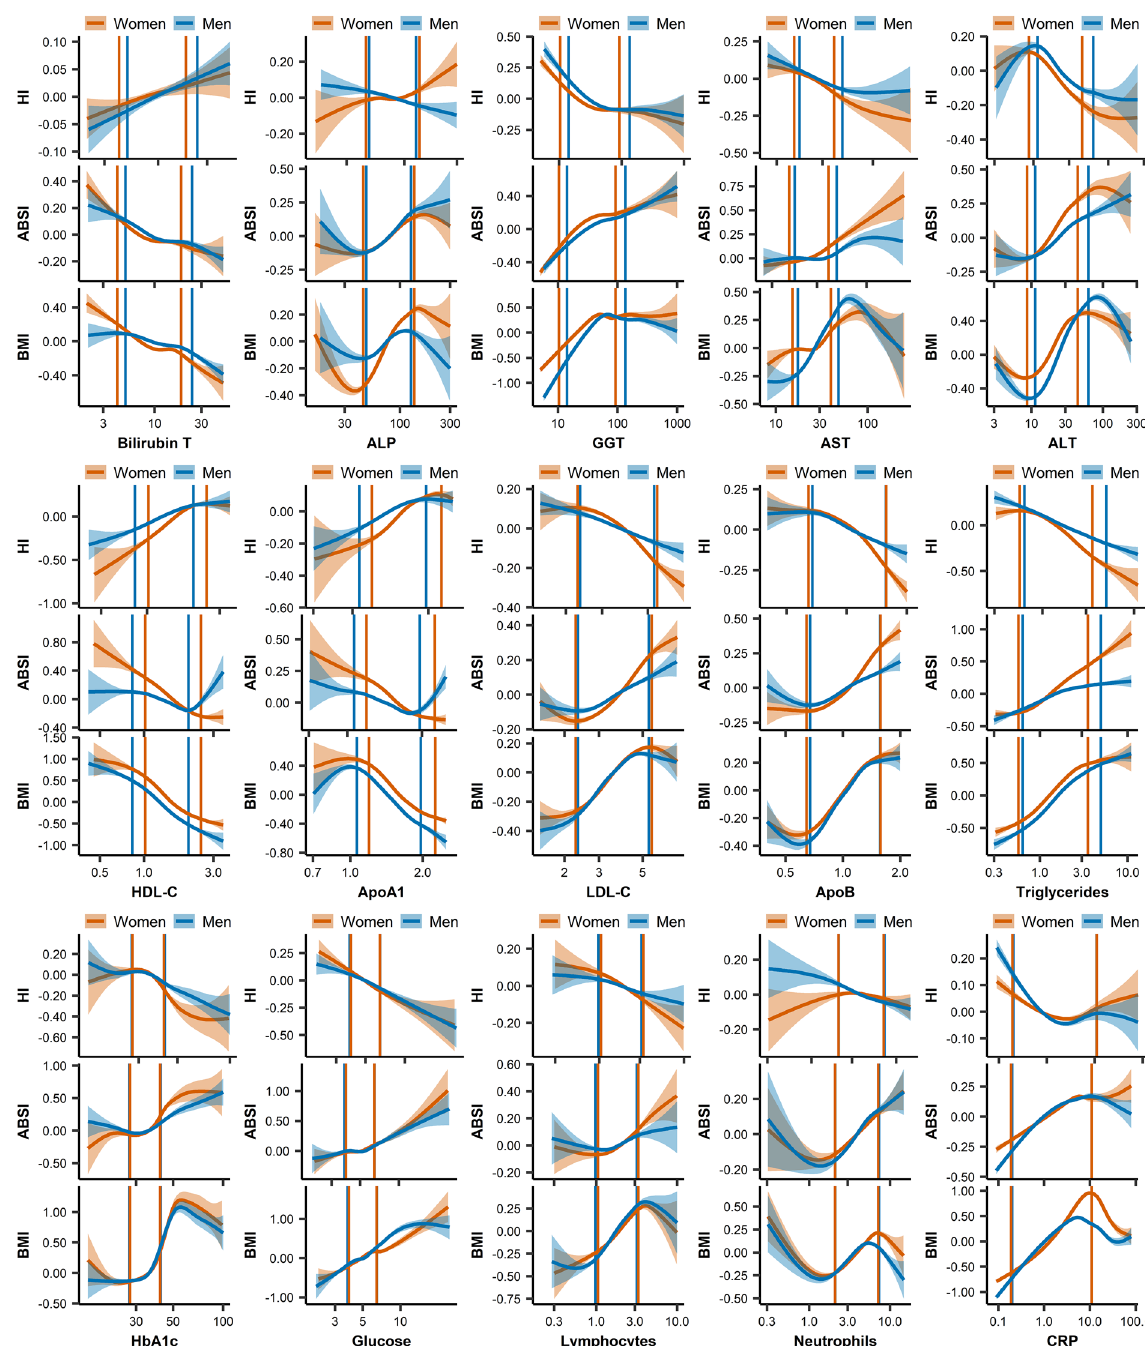
Figure 4. Associations of biomarkers with body size and body shape indices across biomarker levels. ABSI – a body shape index; ALP – alkaline phosphatase (U/L); ALT – alanine aminotransferase (U/L); ApoA1 – apolipoprotein A1 (g/L); ApoB – apolipoprotein B (g/L); AST – aspartate aminotransferase (U/L); Bilirubin T – total bilirubin ( µ mol/L); BMI – body mass index; CRP – C-reactive protein (mg/L); GGT – gamma-glutamyltransferase (U/L); Glucose (mmol/L); HbA1c – haemoglobin A1c (glycated haemoglobin) (mmol/mol); HDL-C – high-density lipoprotein cholesterol (mmol/L); HI – hip index (cut-offs ≥ 49 for men, ≥ 64 for women); LDL-C – low-density lipoprotein cholesterol (mmol/L); Lymphocytes (*10 9 /L); Neutrophils (*10 9 /L); Triglycerides (mmol/L). Plots represent mean of biomarker levels (95% confidence interval), determined with the generalised additive models smoothing function from package mgcv v1.8–39, applied in ggplot2 v.3.3.5 in R v4.1.3., which uses restricted maximum likelihood (REML) estimation. Vertical lines represent 2.5th and 97.5 th sex-specific centiles of the dataset. Extreme values were removed, to avoid leverage on the estimates (see details in Supplementary Table S6). For each of the anthropometric indices, we used residuals derived from a multivariable linear regression model including the other two anthropometric indices and covariates. Covariates comprised height, age at enrolment, weight change within the last year preceding enrolment, smoking status, alcohol consumption, physical activity, Townsend deprivation index, region of the assessment centre, time of blood collection, fasting time, use of nonsteroidal anti-inflammatory drugs, paracetamol use, and in women, menopausal status, hormone replacement therapy use, oral contraceptives use, and age at the last live